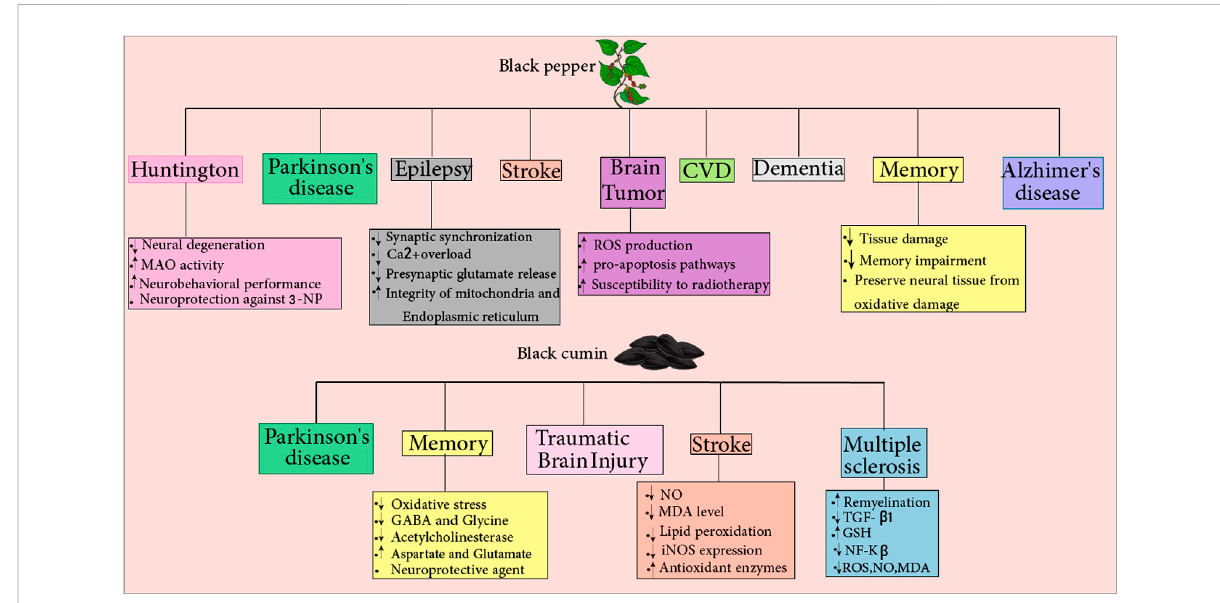
FIGURE 4 Black pepper: this compound reduces the risk of various diseases, such as Huntington ’ s, Parkinson ’ s, epilepsy, stroke, brain tumor, CVD, dementia, memoryloss,and Alzheimer ’ sdisease. Black pepper protects againstHuntington ’ sby reducing neural degenerationand MAO activity and increasing neurobehavioral performance. Additionally, black pepper leads to neuroprotection against 3-NP. Black pepper prevents epilepsy by reducing synaptic synchronization, Ca2+ overload, and presynaptic glutamate release and increasing integrity of mitochondria and endoplasmic reticulum. It also prevents brain tumor by increasing ROS production and pro-apoptosis pathways and increasing susceptibility to radiotherapy.By reducing tissue damage, memory impairment, and preserving neural tissue from oxidative damage black pepper protects against memory loss.Black cumin: This compound reduces the risk ofvariousdiseases, such as Parkinson ’ s, memory loss, traumatic brain injury, stroke, and multiple sclerosis.It prevents memory loss by reducing oxidative stress, GABA, glycine, and acetylcholinesterase and increasing aspartate and glutamate. Also, black cumin is a neuroprotective agent. Black cumin prevents stroke by reducing NO and MDA level, iNOS expression, and lipid peroxidation and increasing antioxidant enzymes. The black cumin protects against multiple sclerosis by increasing remyelination and GSH and reducing NF-K β , ROS, NO, MDA, and TGF- β